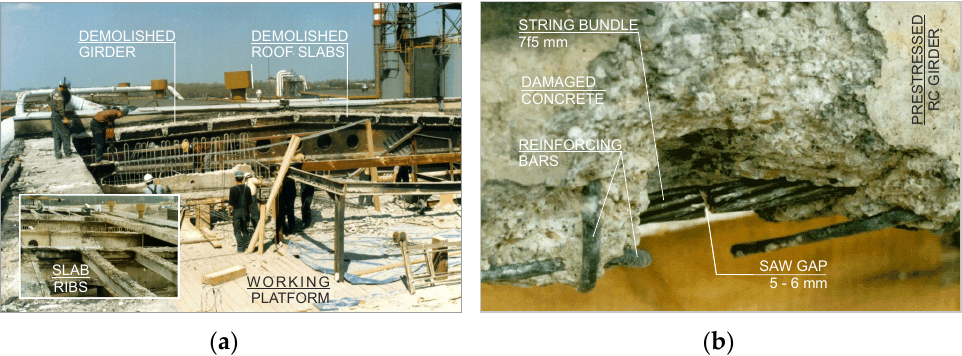
Figure 8. Demolition works of prestressed girders: ( a ) view of the working platform; ( b ) string cut- ting.